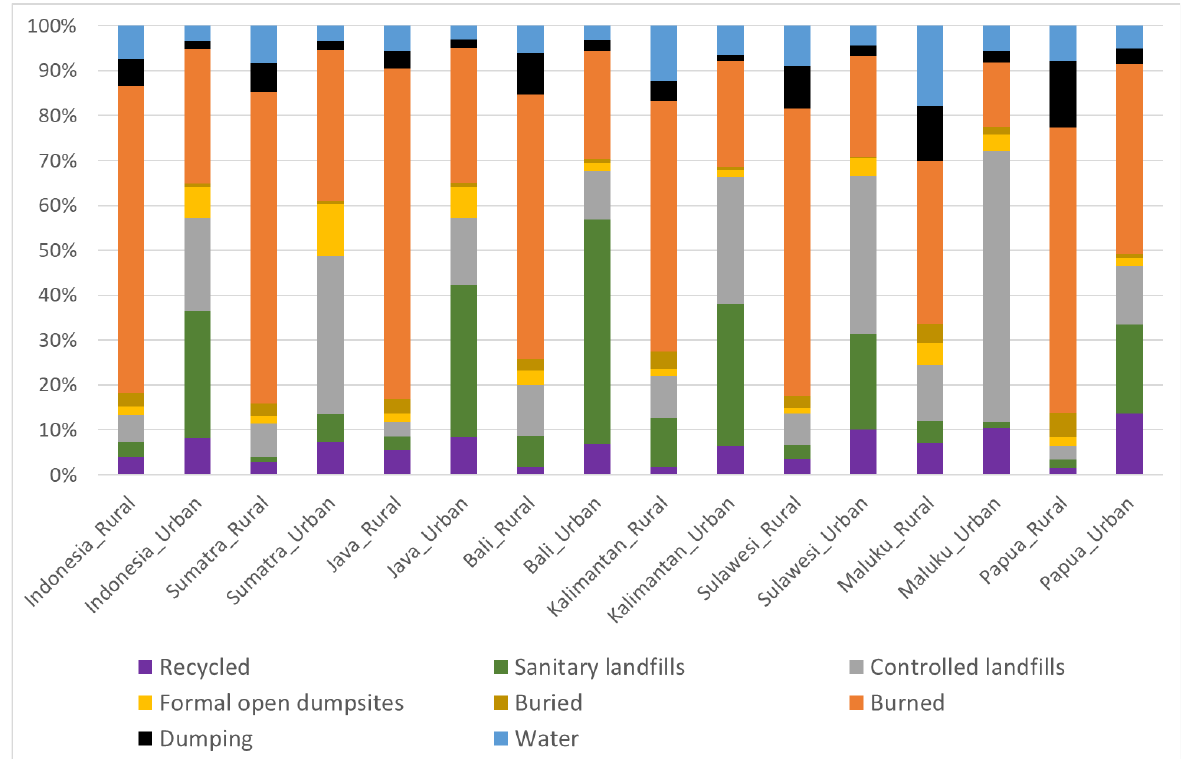
Figure 4. Share (%) of the destination of plastic waste generated in urban and rural areas for the whole of Indonesia and in different regions reveals significant regional differences.